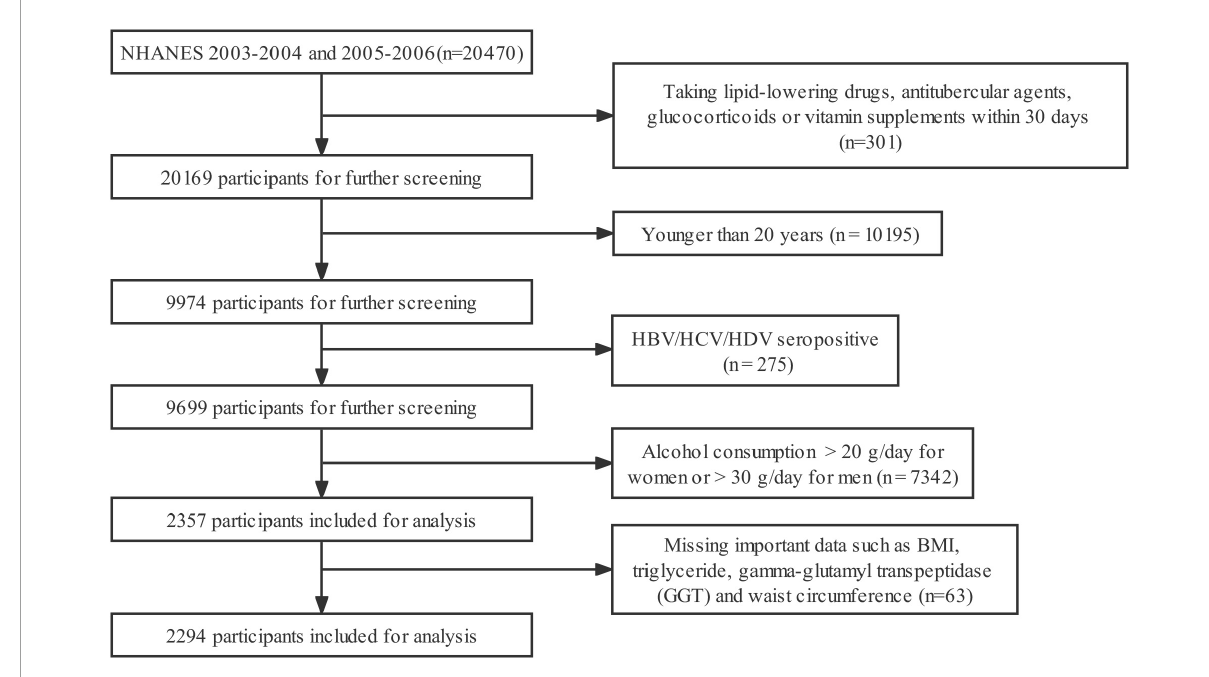
FIGURE1 Flow chart for the selection of participants in the cohort study. HBV, hepatitis B virus; HCV, hepatitis C virus; HDV, hepatitis D